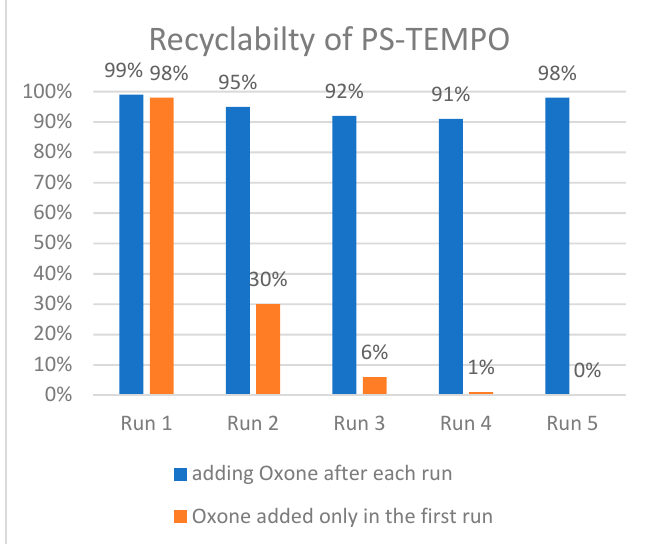
Figure 2. Recyclability study of PS-TEMPO. Table 2. Comparison of PS-TEMPO with non-supported TEMPO.